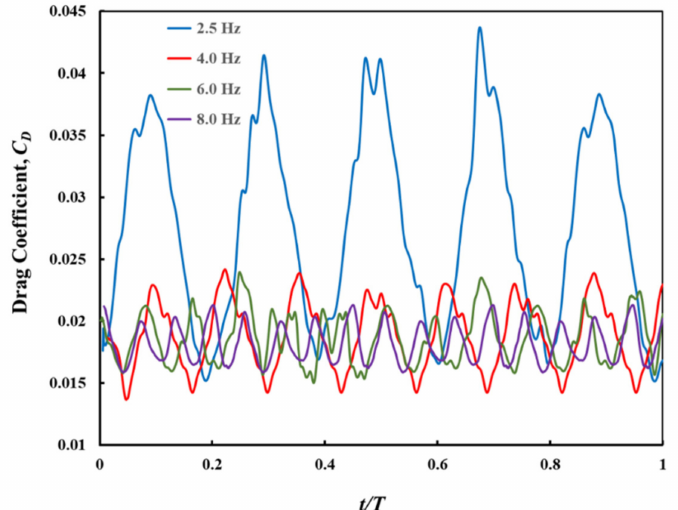
Figure 6. Instantaneous drag coefficient for the station TLC with no obstruction.